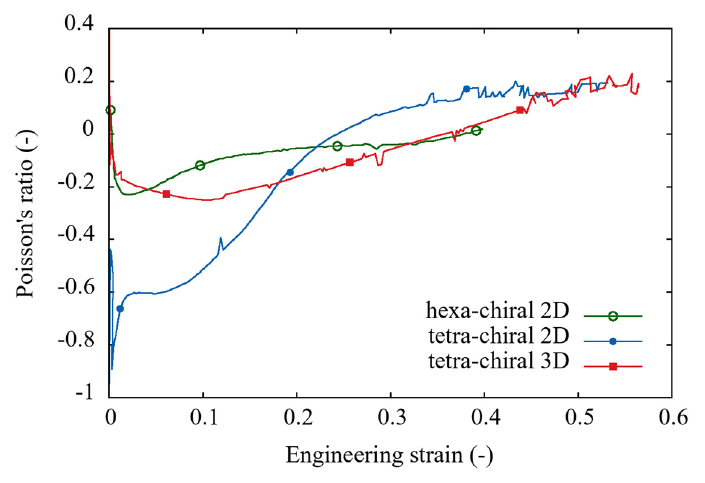
Figure 4. Average quasi-static Poisson’s ratio-strain relationships of hexa-chiral 2D, tetra-chiral 2D, and tetra-chiral 3D structure.